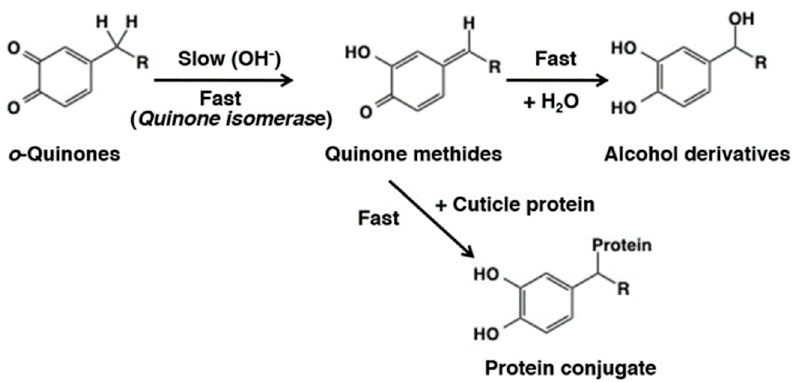
Figure 18. Quinone methide formation from o -quinones and the subsequent addition of water molecule to form alcohol derivatives [84].